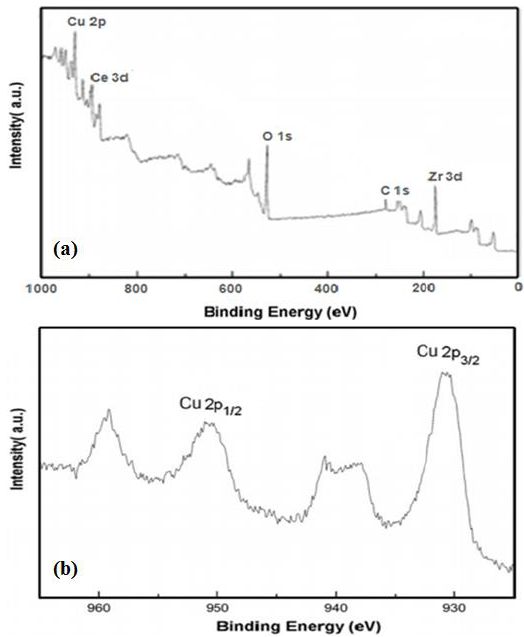
Fig.4. The survey (A) and Cu 2p